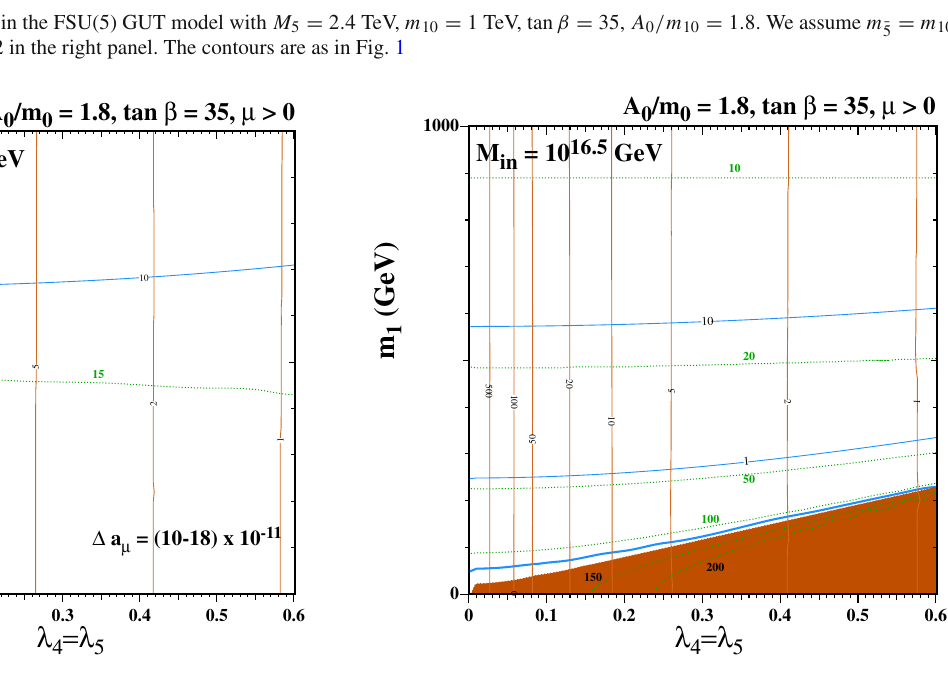
Fig. 10 Representative (λ 4 = λ 5 , m 1 ) planes in the FSU(5) GUT model. In both panels, A 0 / m 0 = 1 . 8, tan β = 35 and M in = 10 16 . 5 GeV. In the left panel M 5 = 2 . 4 TeV, M X 1 = 0 . 8 TeV and m 10 =